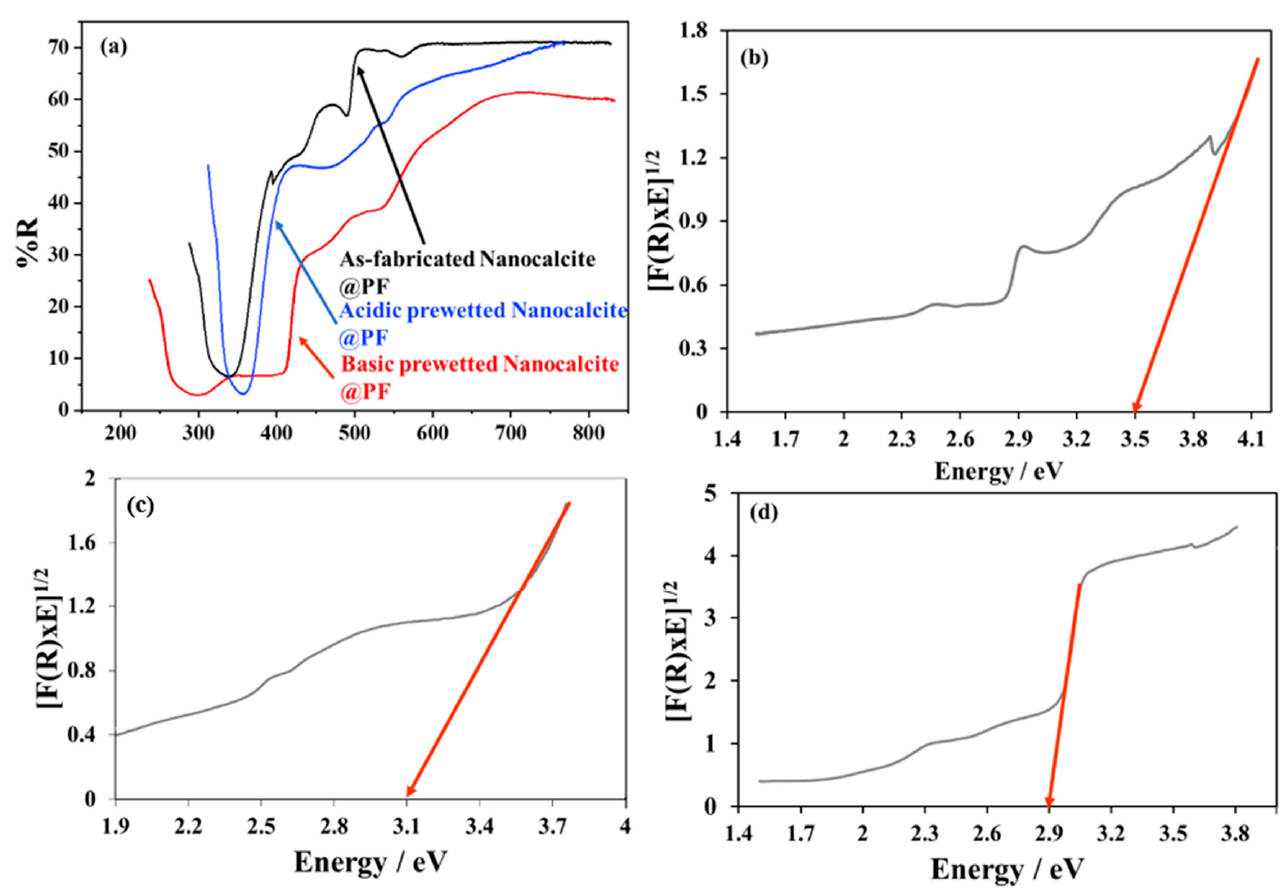
Figure 5. ( a ) Comparative diffused reflectance spectra of the as-fabricated and basic